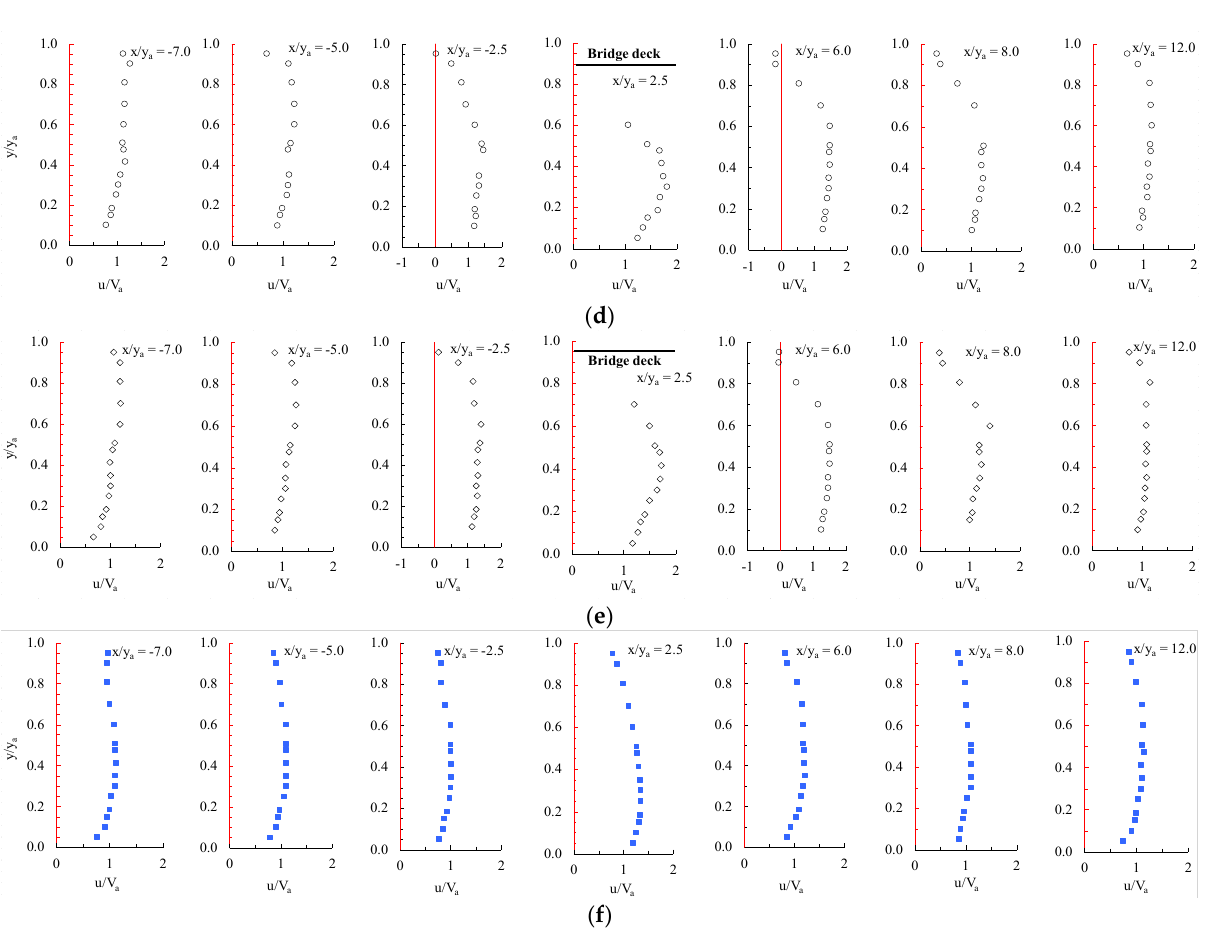
Figure 6. Vertical distributions of the nondimensional mean streamwise velocity u / V a at centerline of the channel and at different nondimensional streamwise distances x / y a , F a * = 0.236 and at: ( a ) y b /y a = 0.35; ( b ) y b /y a = 0.55; ( c ) y b /y a = 0.65; ( d ) y b /y a = 0.75; ( e ) y b /y a = 0.80; and ( f ) y b /y a = 1.00 (no deck).